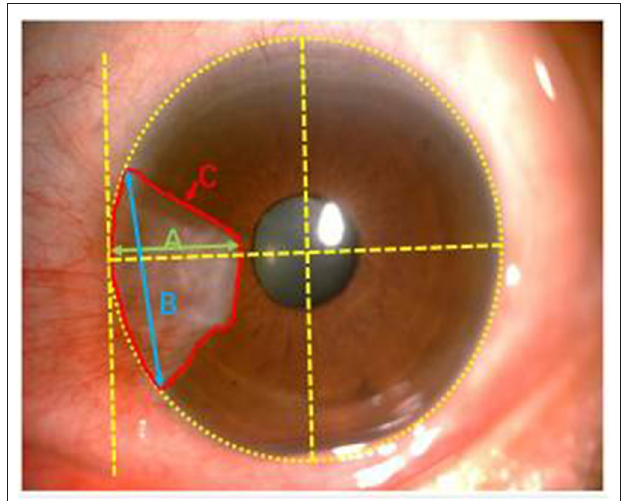
FIGURE 2 | Illustration of the pterygium and macular retinal thickness area: As shown in the figure, see the pterygium of the nasal limbus of the left eye and the macula of the